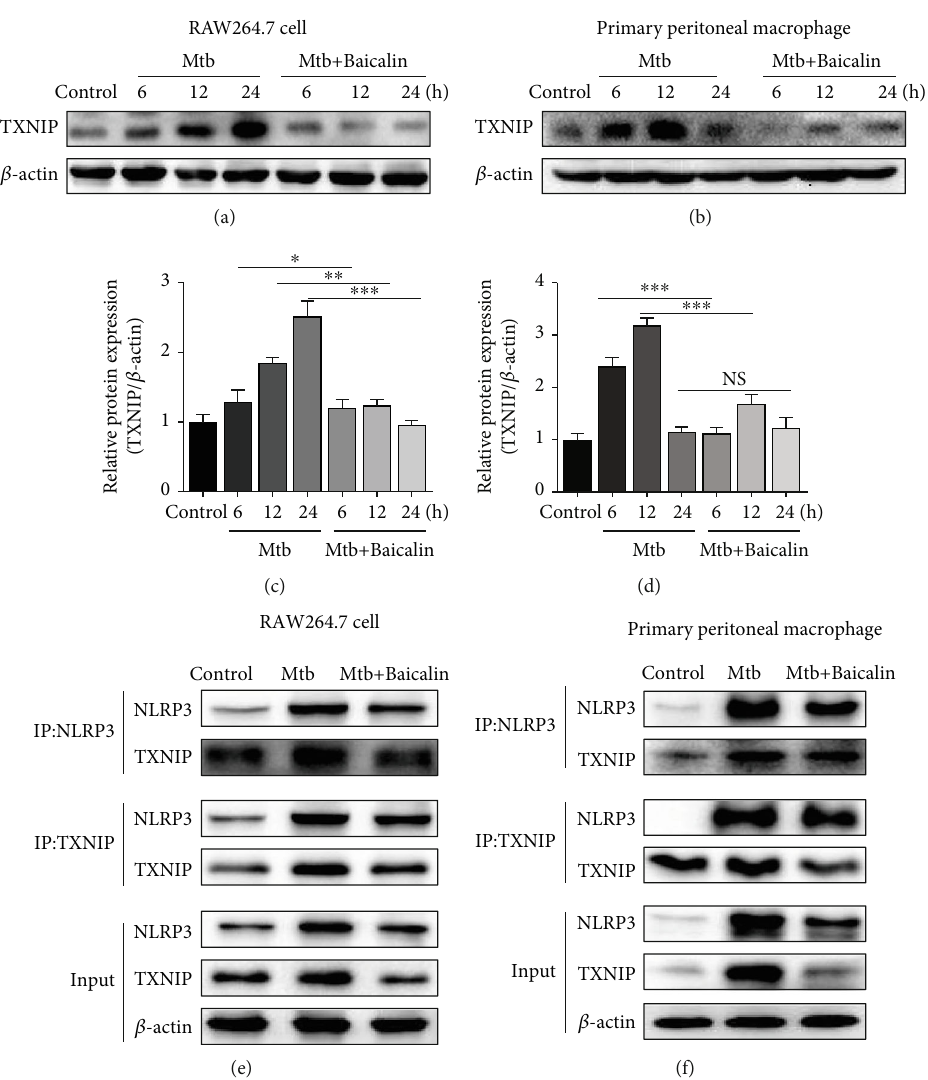
Figure 2: Baicalin reduces TXNIP-NLRP3 interactions in Mtb-infected macrophages. (a, c) Levels of TXNIP protein detected by western blotting analysis in RAW264.7 cells. (b, d) Levels of TXNIP protein determined by western blotting in primary peritoneal macrophage cells. (e, f) TXNIP or NLRP3 immunoprecipitated from RAW264.7 cells and primary peritoneal macrophage cells were immunoblotted for TXNIP or NLRP3, respectively, and reblotted for TXNIP or NLRP3, respectively. Experiment performed three times. ∗ p < 0 : 05 ; ∗∗ p < 0 : 01 ; ∗∗∗ p < 0 : 001 ; NS: nonsigni fi